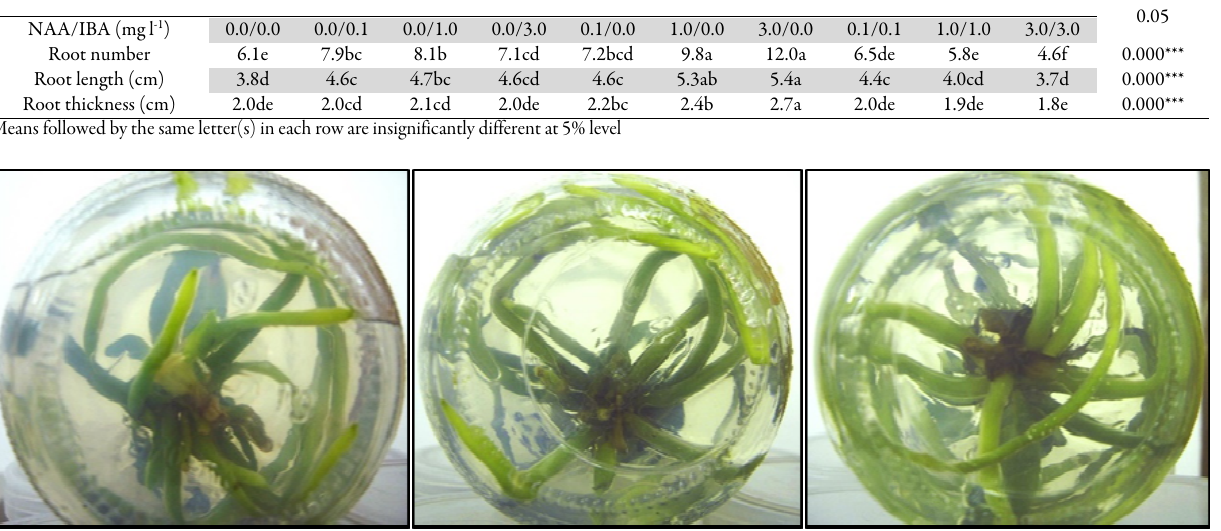
Table 2. Effect of different concentrations of NAA and IBA (mg l -1 ) on root number, length and width of in vitro orchid plantlets Treatments